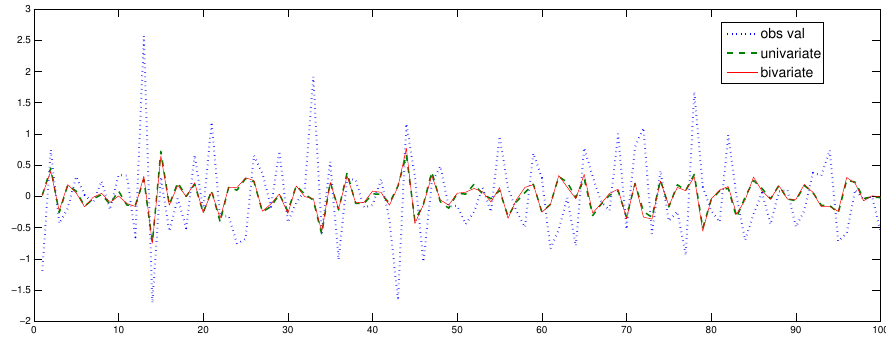
Figure 8: Pointwise predictions using the conditional expectation of the univariate (dashed line) and the bivariate model (plain line). Observed values are shown by the dotted